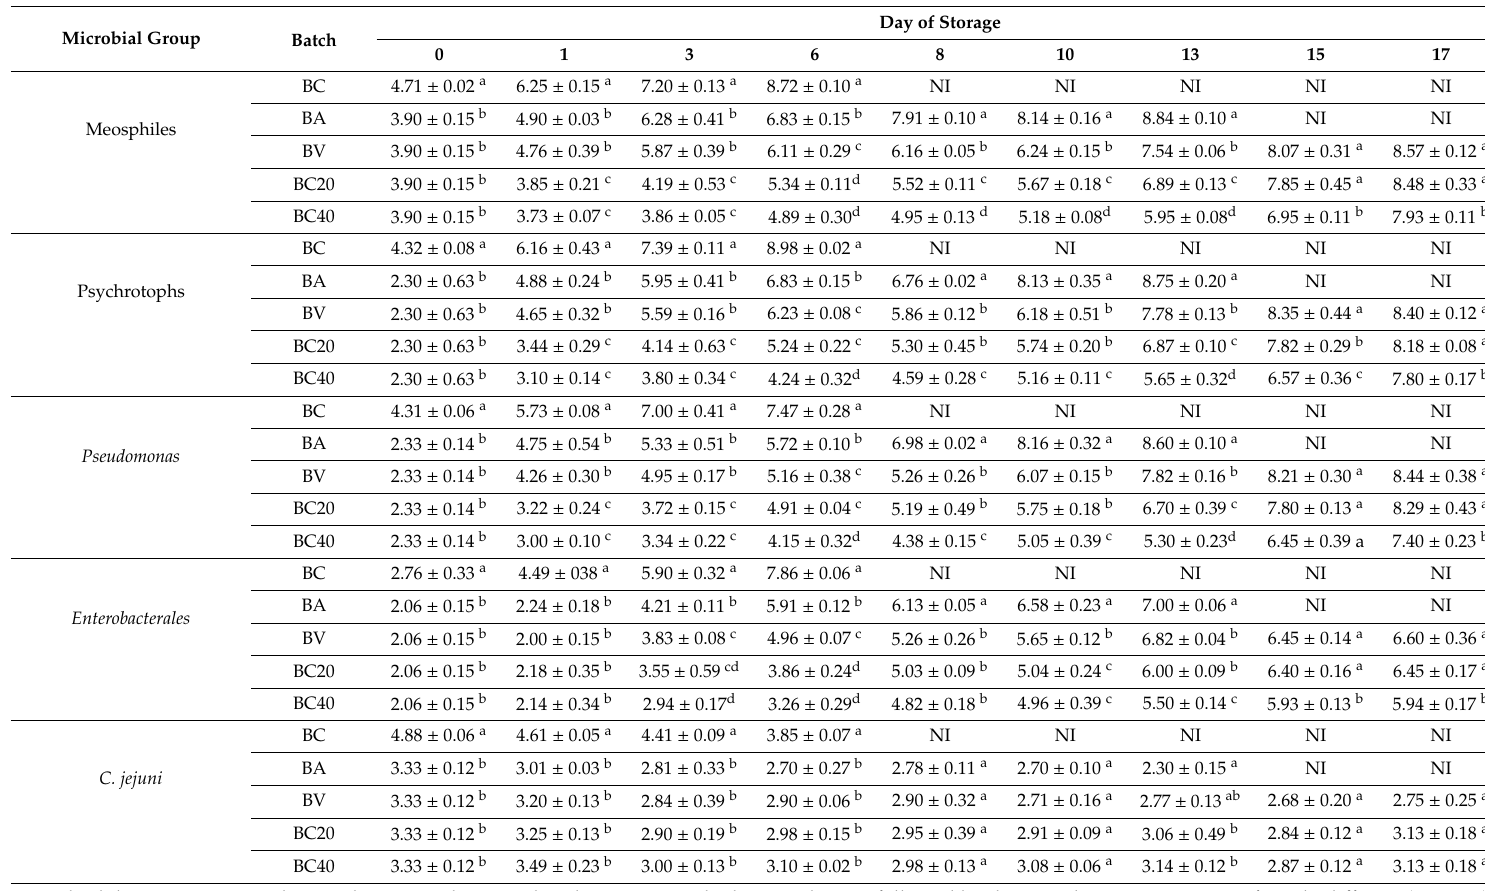
Table 5. E ff ect of 2% lactic acid on the mesophilic, psychrotrophic, Pseudomonas, Enterobacterales , and C. jejuni counts on chicken legs packaged under di ff erent modified atmospheres (log cfu /